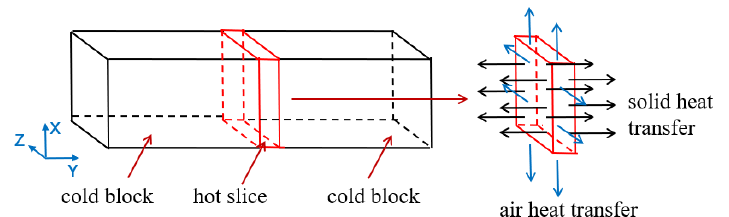
Figure 9. Simplified schematic diagram of cooling.